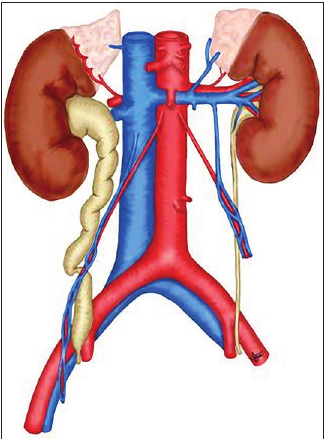
FIGURE 3. An anatomic illustration of right ureteral compression by the right external iliac